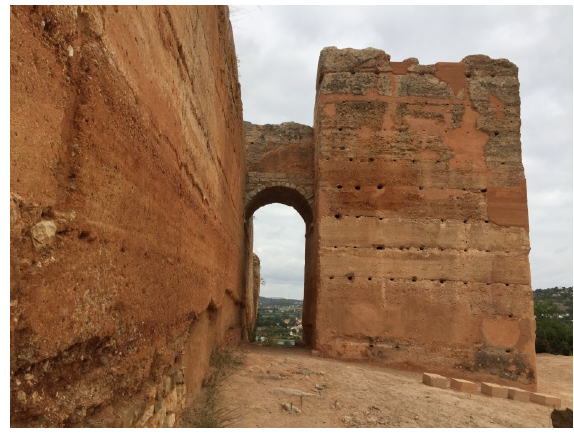
Figure 4. Paderne Castle (12th century) in Algarve,